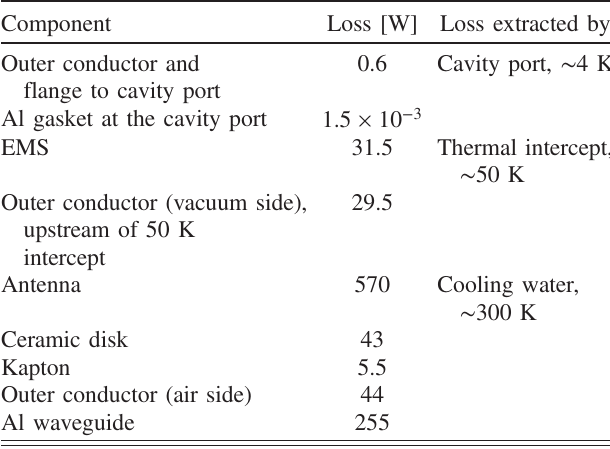
TABLE V. Losses in the coupler components for 500 kW forward propagation and 10% reflection.